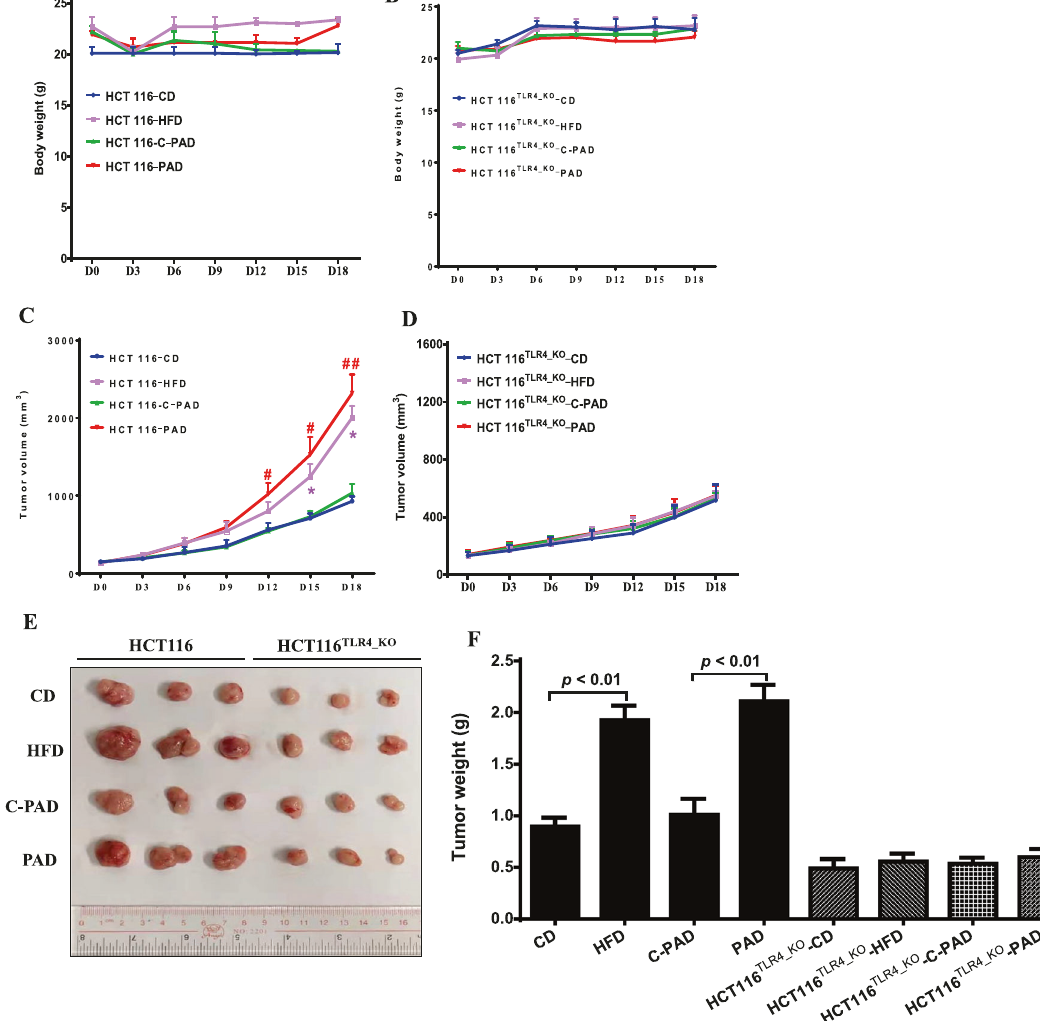
Fig. 5 HFD or palmitic acid-rich diet (PAD) increases CRC growth in a TLR4-dependent manner in vivo. The body weight of the xenograft mouse models that were inoculated with A wild-type HCT116 cells or B HCT116 TLR4-KO cells, during the 18-day dietary intervention. The tumor volume of the xenograft mouse models that were inoculated with C wild-type HCT116 cells or D HCT116 TLR4-KO cells, during the 18-day dietary intervention. E Pictures of the dissected tumor tissues. F The tumor weight of the xenograft mouse models that were inoculated with wild- type HCT116 cells or HCT116 TLR4-KO cells, after the dietary intervention. HFD high-fat diet, CD matched control diet for HFD, PAD palmitic acid- rich diet, C-PAD matched control diet for PAD. Data are shown as means ± SEM, n = 3 mice in each group. * p < 0.05 compared with CD, # p < 0.05, ## p < 0.01 compared with